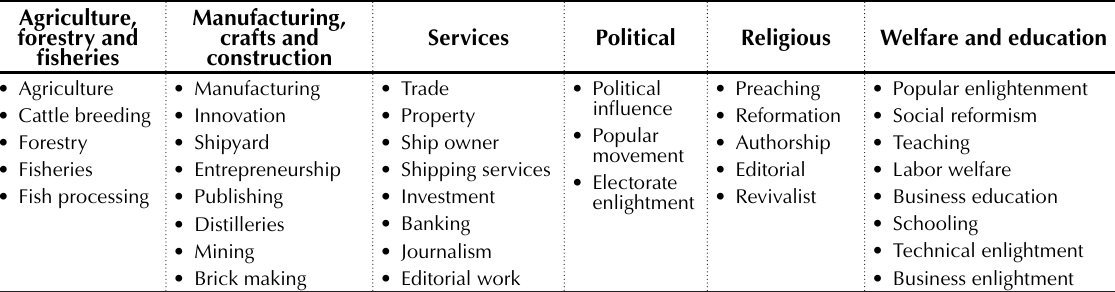
Table 1. Portfolio of Hauge’s engagement Agriculture, forestry